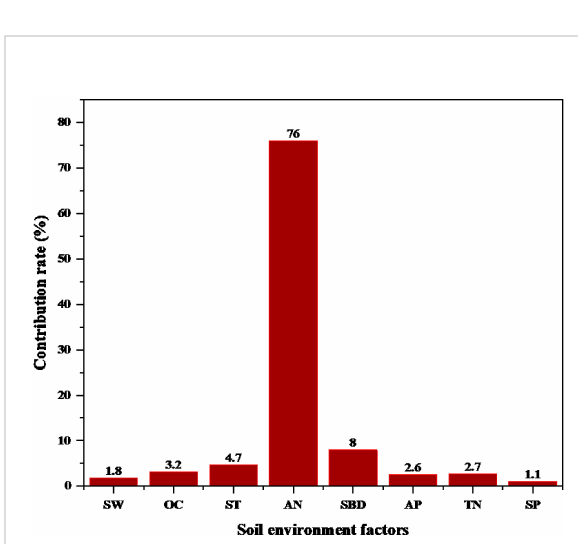
FIGURE 11 Contribution rates of soil environmental factors affecting fi ne root morphology. AN, alkaline nitrogen; SBD, soil bulk density; AP, available phosphorus; SW, soil moisture; OC, organic carbon; ST, soil temperature; TN, total nitrogen; SP, soil